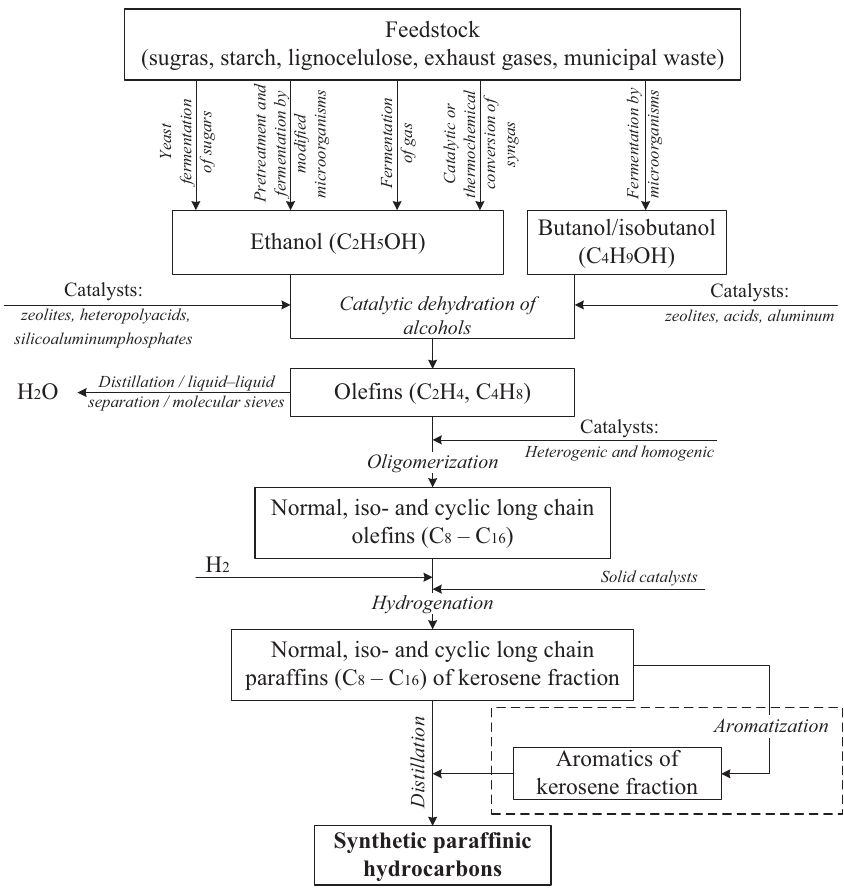
Figure 2. The overall scheme of the AtJ fuel production process (source: author